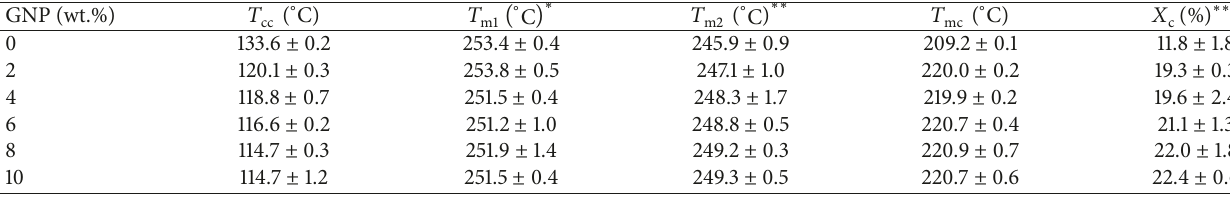
Table 2: DSC data for PET-GNP nanocomposites.